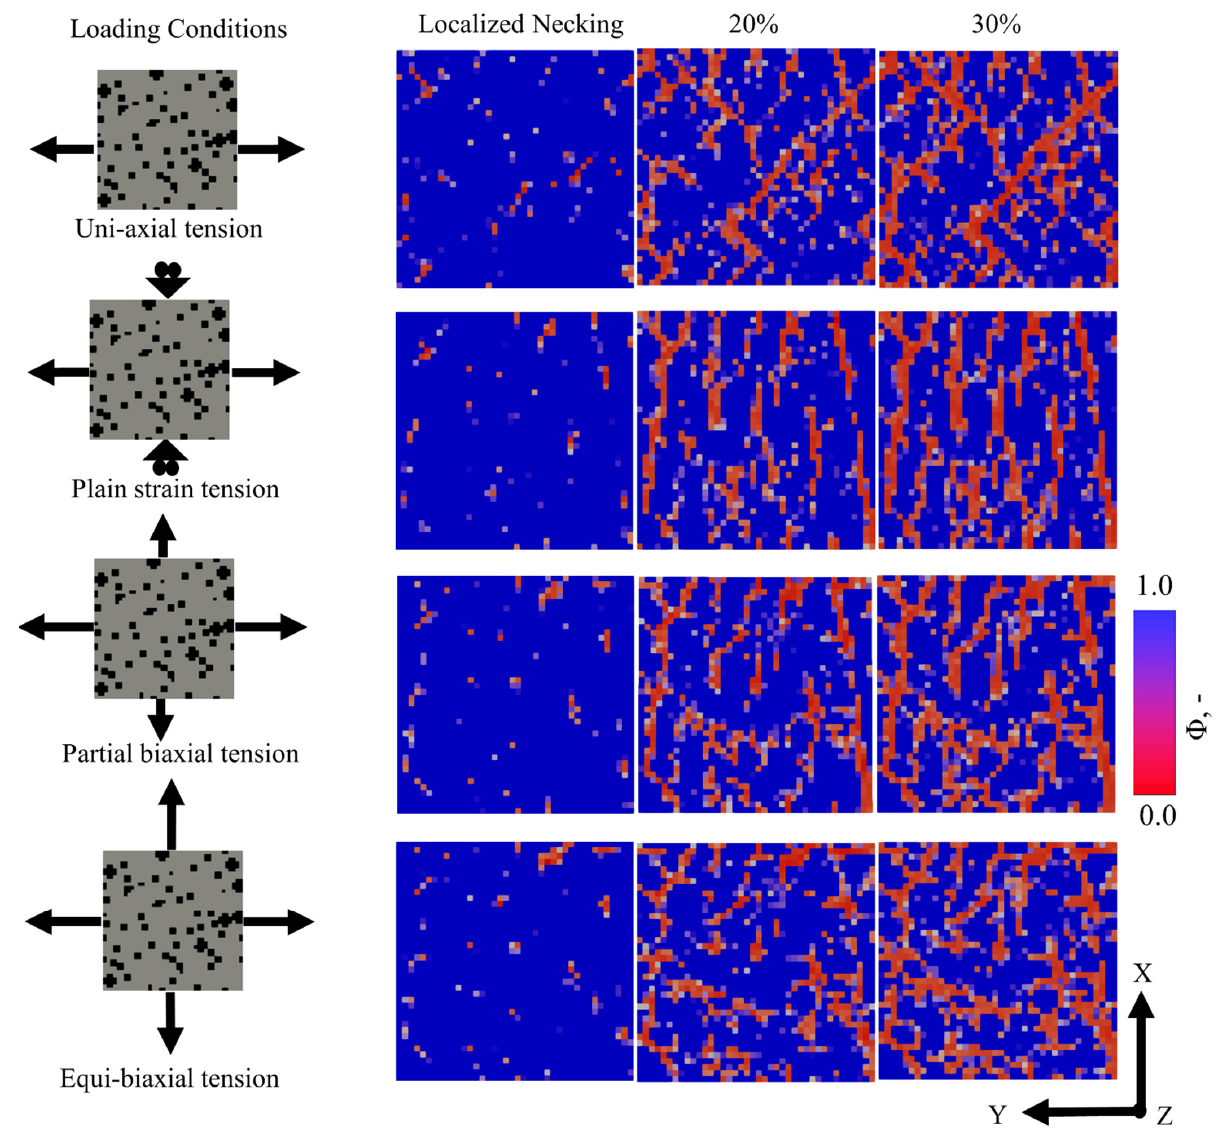
Figure 11. Damage behavior of dual-phase steels in model A with martensite grain sizes = 2.7